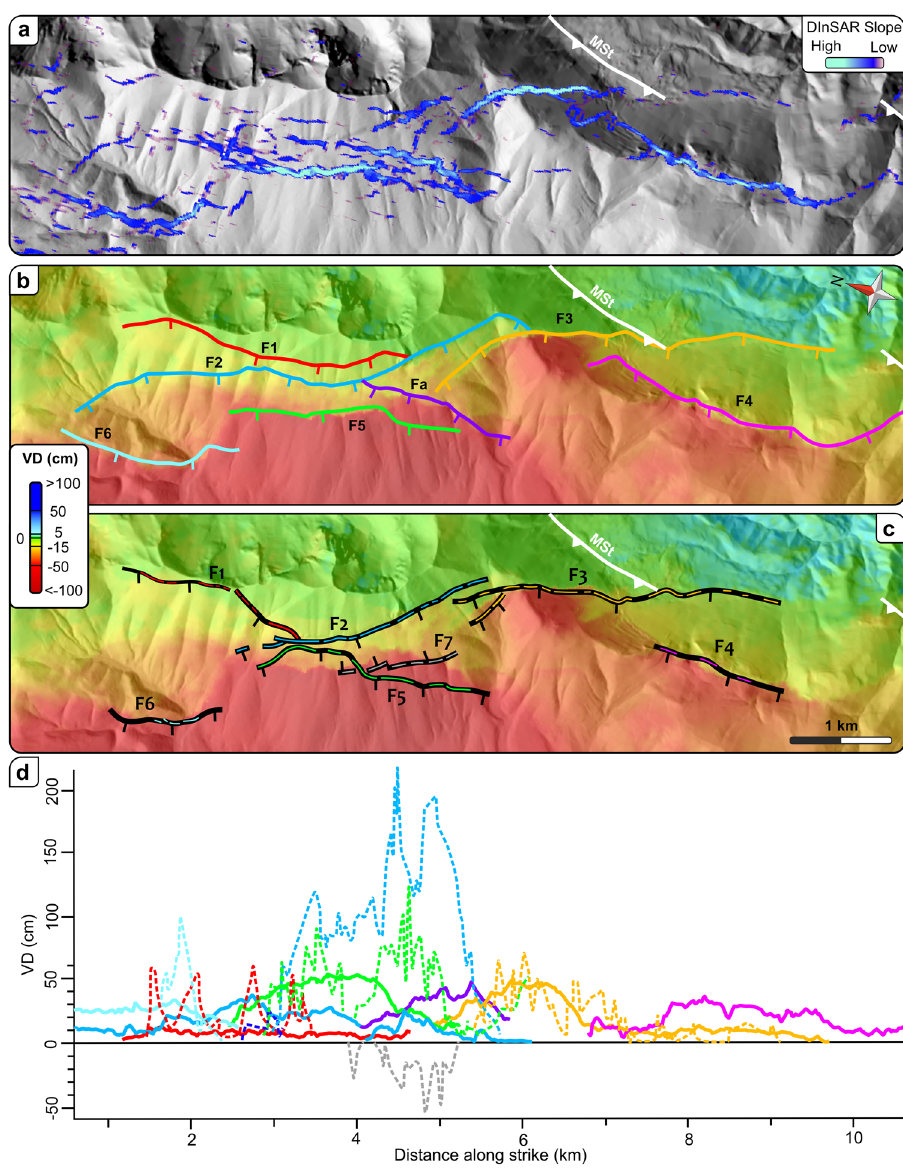
Figure 4. Comparison of field and DInSAR results of the M. Vettore area. ( a ) Slope distribution obtained from the VDM1, superimposed on the DEM. ( b) Coseismic ruptures derived from the VDM1. ( c) Coseismic ruptures mapped in the field 8 . The white lines mark the trace of the M. Sibillini Thrust (MSt). ( d ) Comparison of the vertical displacement (VD) accrued by single ruptures as observed in the field (dotted lines) and from the VDM1 (continuous